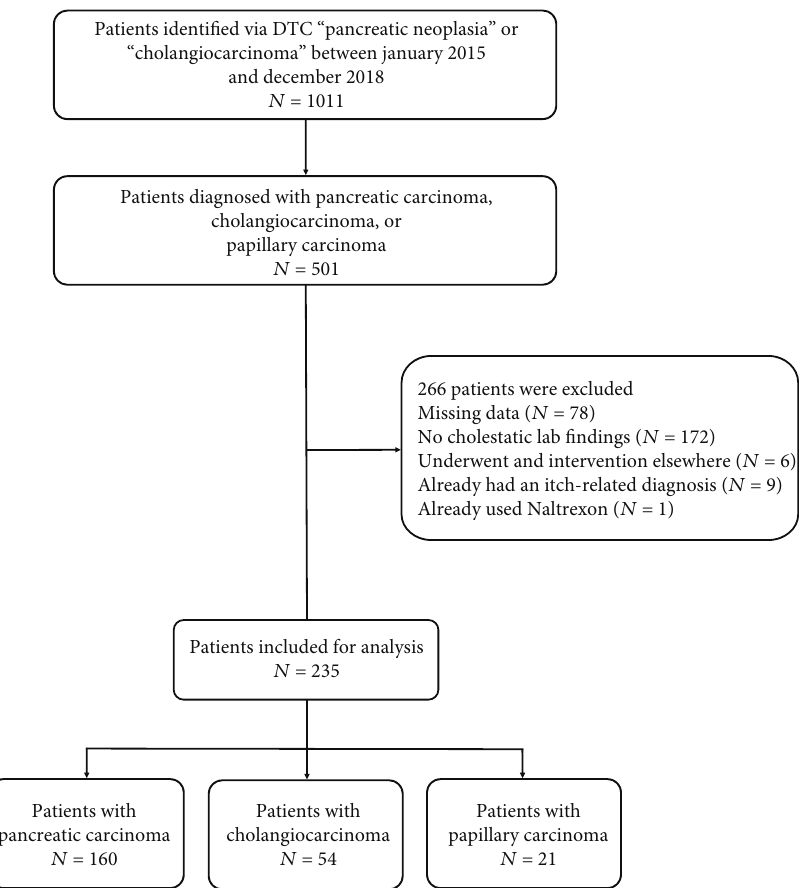
Figure 1: A schematic overview of included